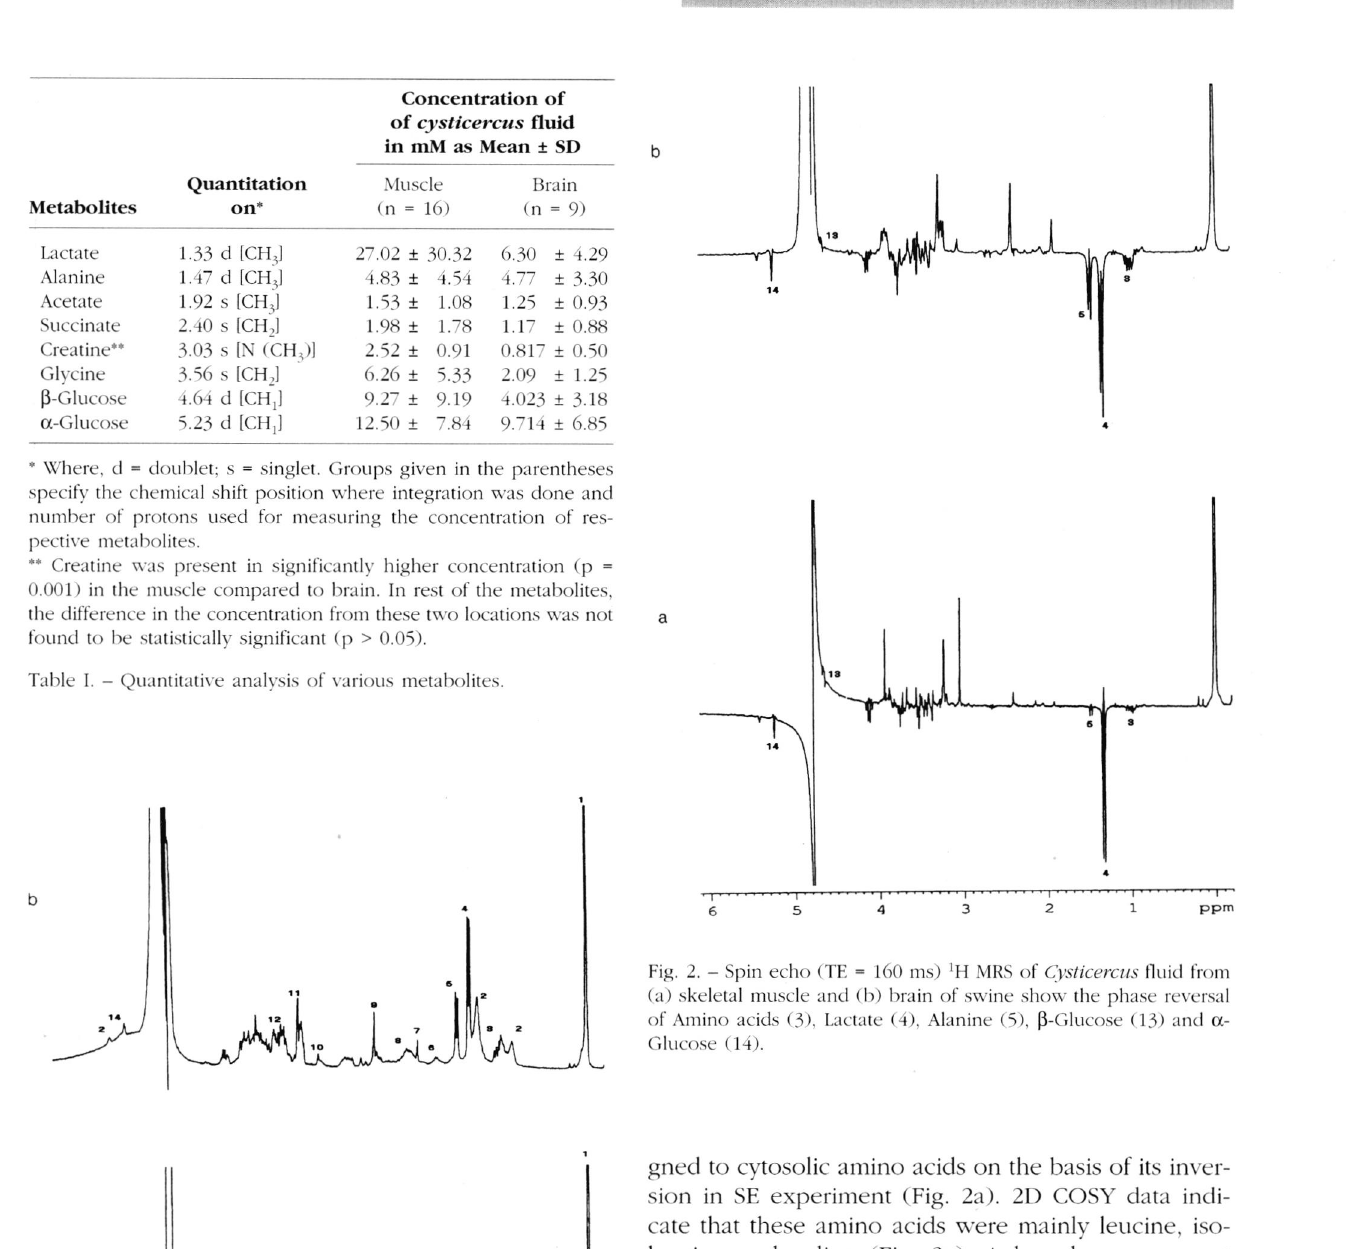
Fig. 2. - Spin echo (TE = 160 ms) 1 H MRS of Cysticercus fluid from (a) skeletal muscle and (b) brain of swine show the phase reversal of Amino acids (3), Lactate (4), Alanine (5). B -Glucose (13) and a- Glucose